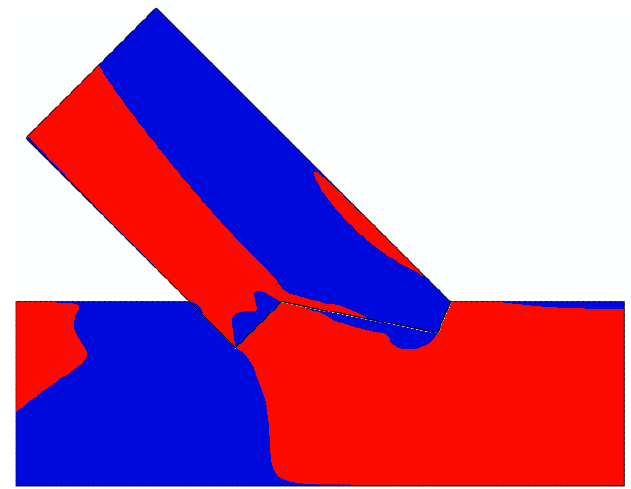
Figure 24. Shear stress distribution: negative (blue) and positive values (red).